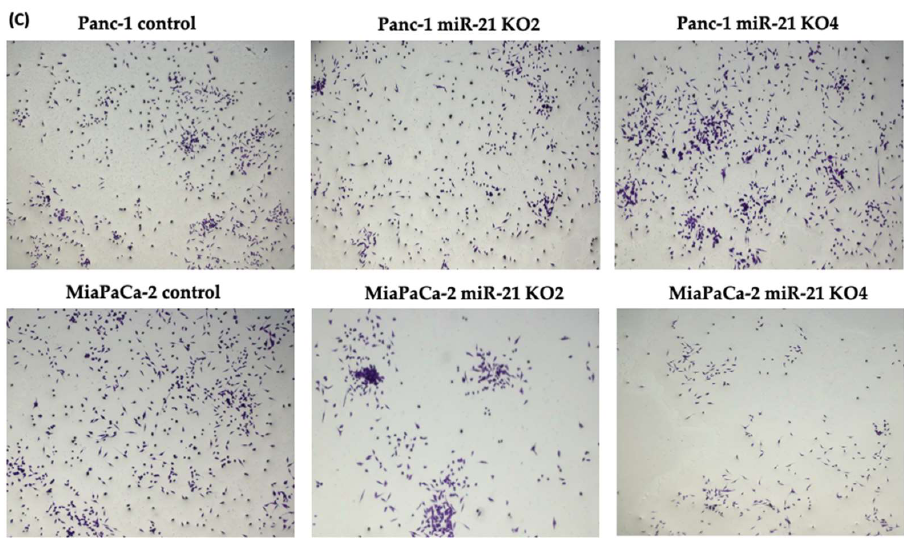
Figure 7. miR-21 reduced cellular invasion of Panc-1 and MiaPaca-2 cells. ( A ) Control and miR-21 KO cells were plated on Matrigel-coated transwell filters and the extent of invasion was determined after 16 h. The results are plotted as Relative Cell Invasion (%), which is the percentage of invaded cells compared to the total number of cells seeded. ( B) The total cell number/proliferation did not change during the course of the experiment in the Panc-1 miR-21 KOs ( n = 3; p > 0.05 for all), however, a small significant reduction was detected in the MiaPaCa-2 miR-21 KOs ( n =3; p < 0.01 for all). ( C ) Colony formation assay for Panc-1 and MiaPaCa-2 control and miR-21 KO cells. The colonies were observed with crystal violet staining of cells following 12 days. Images were obtained by using EVOS FL Auto 2 Imaging System (ThermoFisher, UK) with 10x magnification. p -values are indicated as ** p ≤ 0.01; *** p ≤ 0.001; **** p ≤ 0.0001; error bars indicate SD.